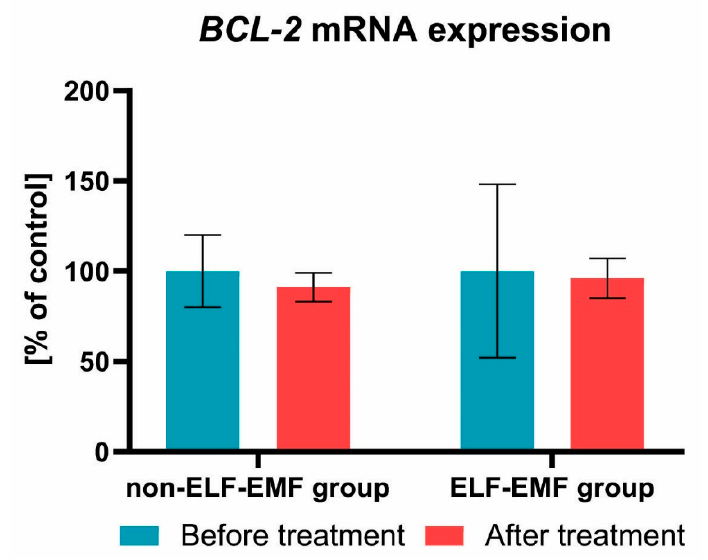
Figure 3. Comparison of the BCL-2 mRNA expression acquired from the study group vs. control. Results formulated as parameter changes before and after therapy (100% expressed for the level of BCL-2 mRNA expression in each patient sample before treatment).